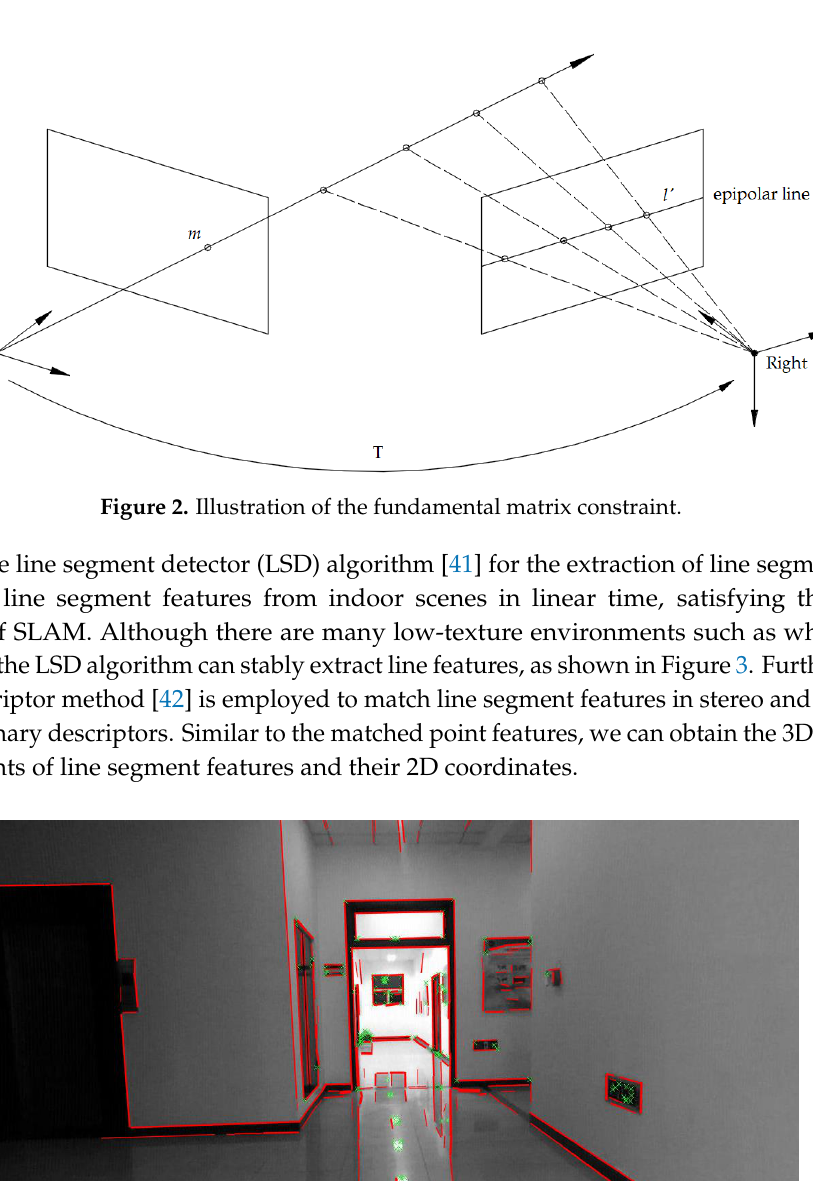
Figure 1. Flowchart of our proposed visual SLAM method